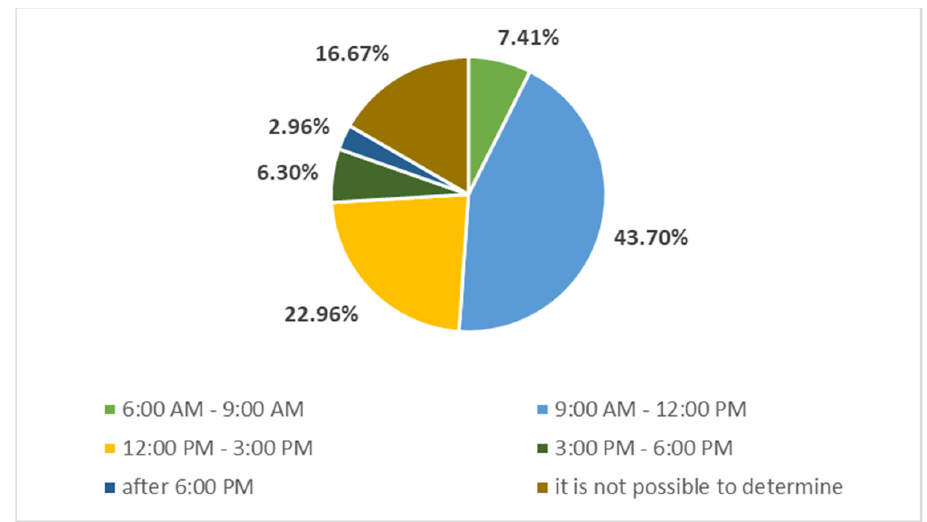
Figure 4. The part of the day with the highest disturbance. Source: own research, own processing. The majority of respondents (43.70%) are most disturbed in the time from 9 a.m. to 12 p.m., which again confirmed the views of individual authors [36–39] regarding disturb- ance curves. Between 12 p.m. and 3 p.m., 22.96% of respondents are the most disturbed.